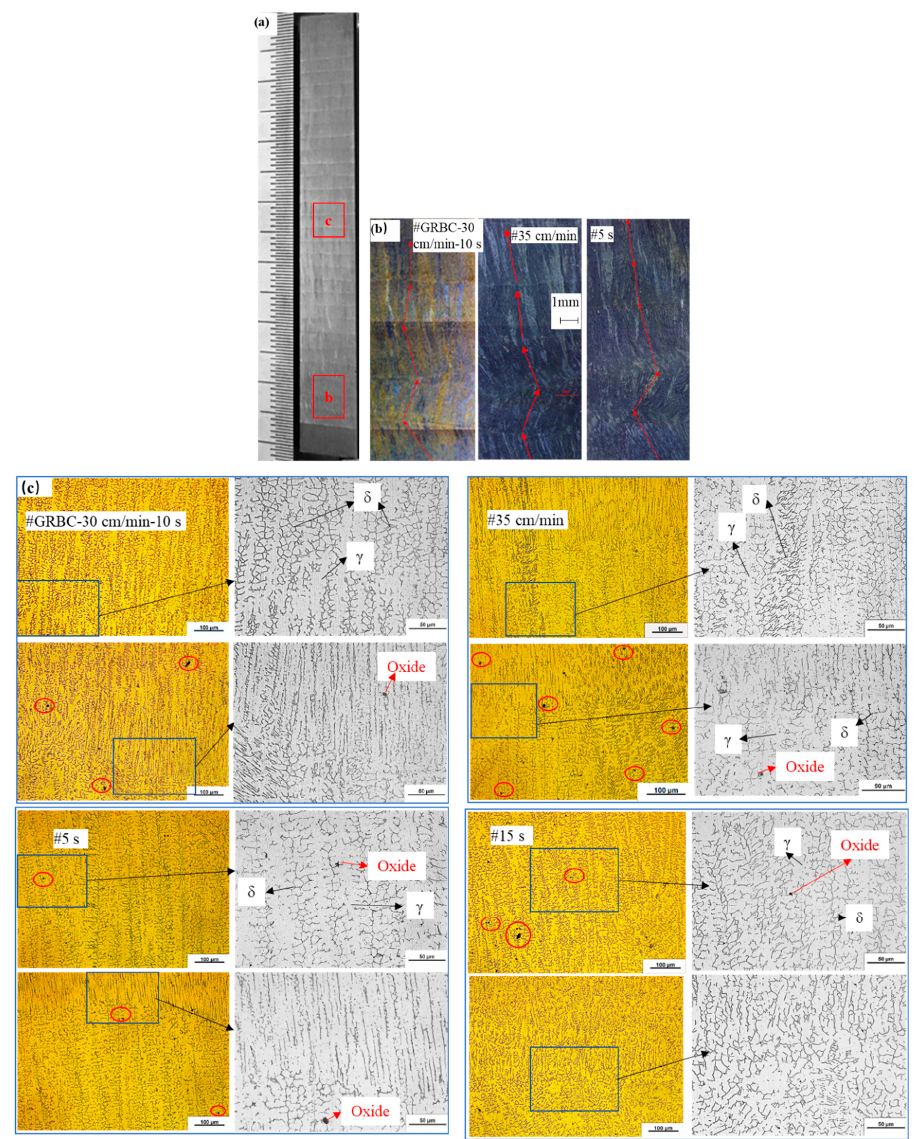
Figure 7. Longitudinal-section micrographs of 316L deposited samples: ( a ) Sample #GRBC-30 cm/min-10 s; ( b , c ) middle and bottom parts of different samples, respectively. ( b , c ) Correspond to the middle and bottom regions of ( a ), respectively. (TRBC and GRBC represent transient and gradual reduction of bottom current, respectively).